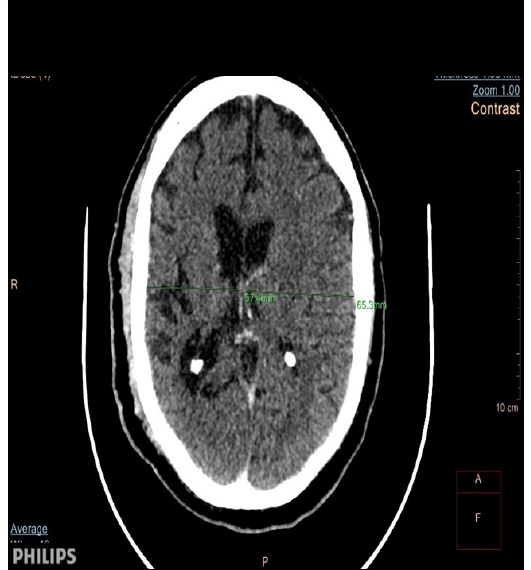
Figure 2. CT scan of the brain (axial view). Shows asymmetry of the lateral ventricles (right to left) with a notable atrophy of the right cerebral hemisphere.